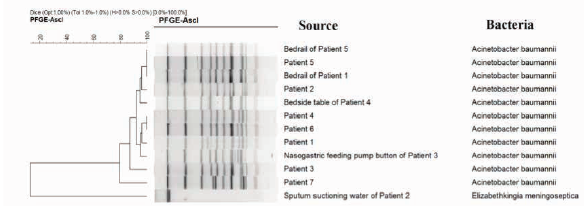
Figure 2: Analysis using the BioNumerics (version 6.5) software for the samples from seven patient cases and five environmental